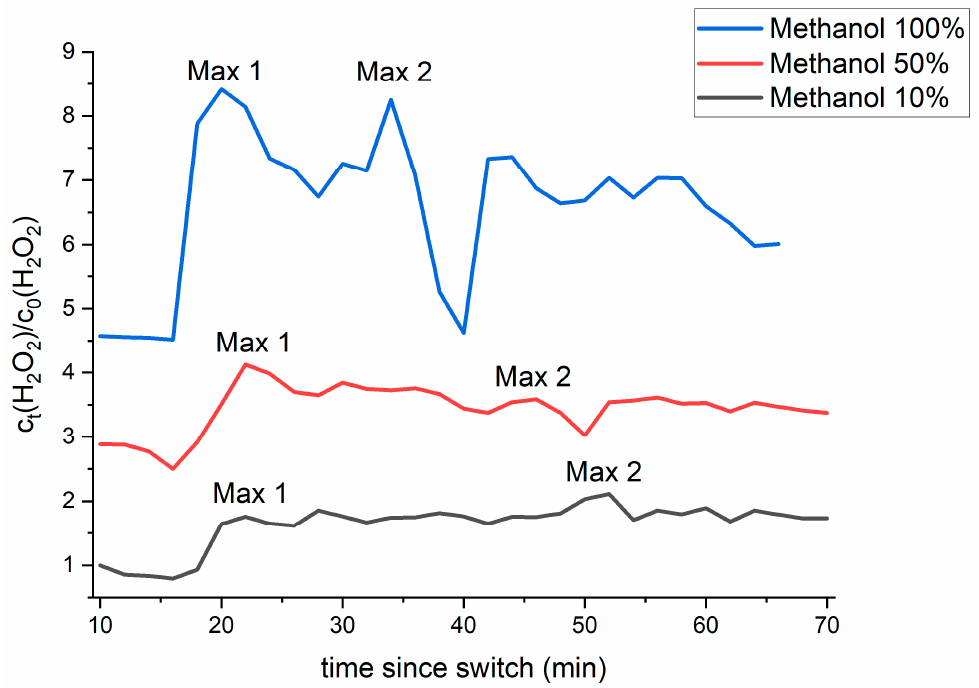
Figure 1. Relative transient response of ratio of hydrogen peroxide concentrations ( c measured with a change in methanol concentration after the switch from water to different methanols ( ϑ = 15 °C).